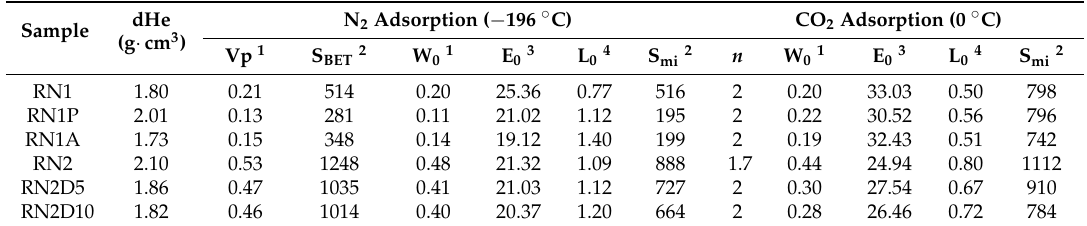
Table 2. Textural parameters of the samples obtained from the N 2 and CO 2 adsorption isotherms. Sample